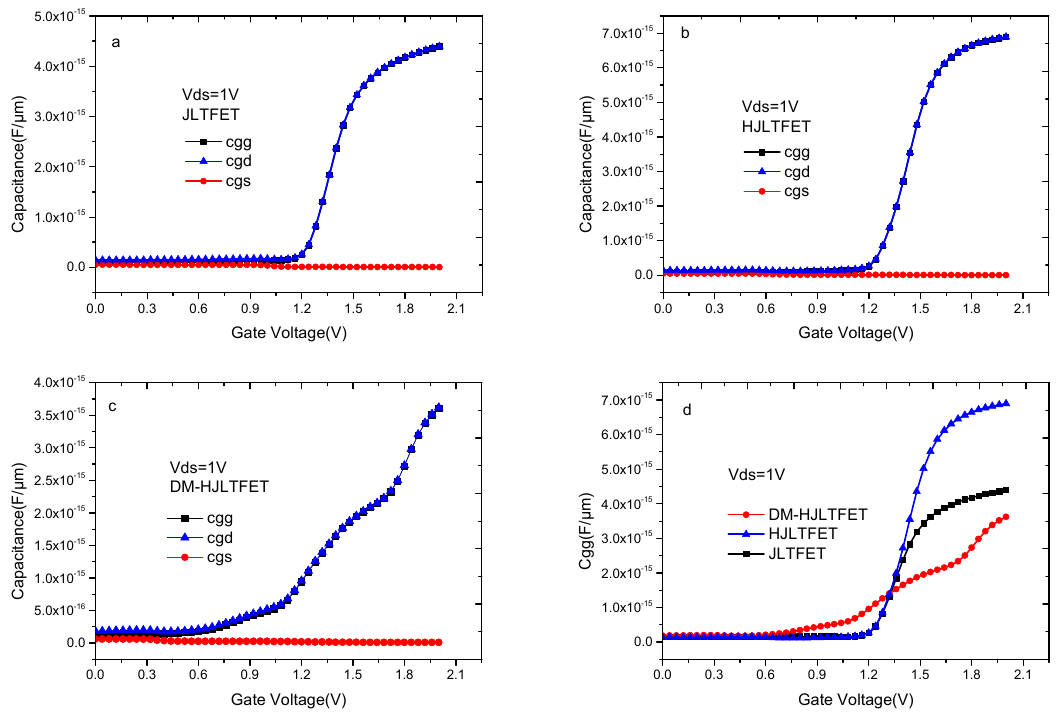
Figure 11. ( a ) Capacitance of JLTFET versus Vgs; ( b ) capacitance of HJLTFET versus Vgs; ( c ) capacitance of DMMG-HJLTFET versus Vgs; ( d ) comparison of Cgg (gate capacitance) of JLTFET, HJLTFET and DMMG-HJLTFET versus Vgs under Vds = 1.0 V.